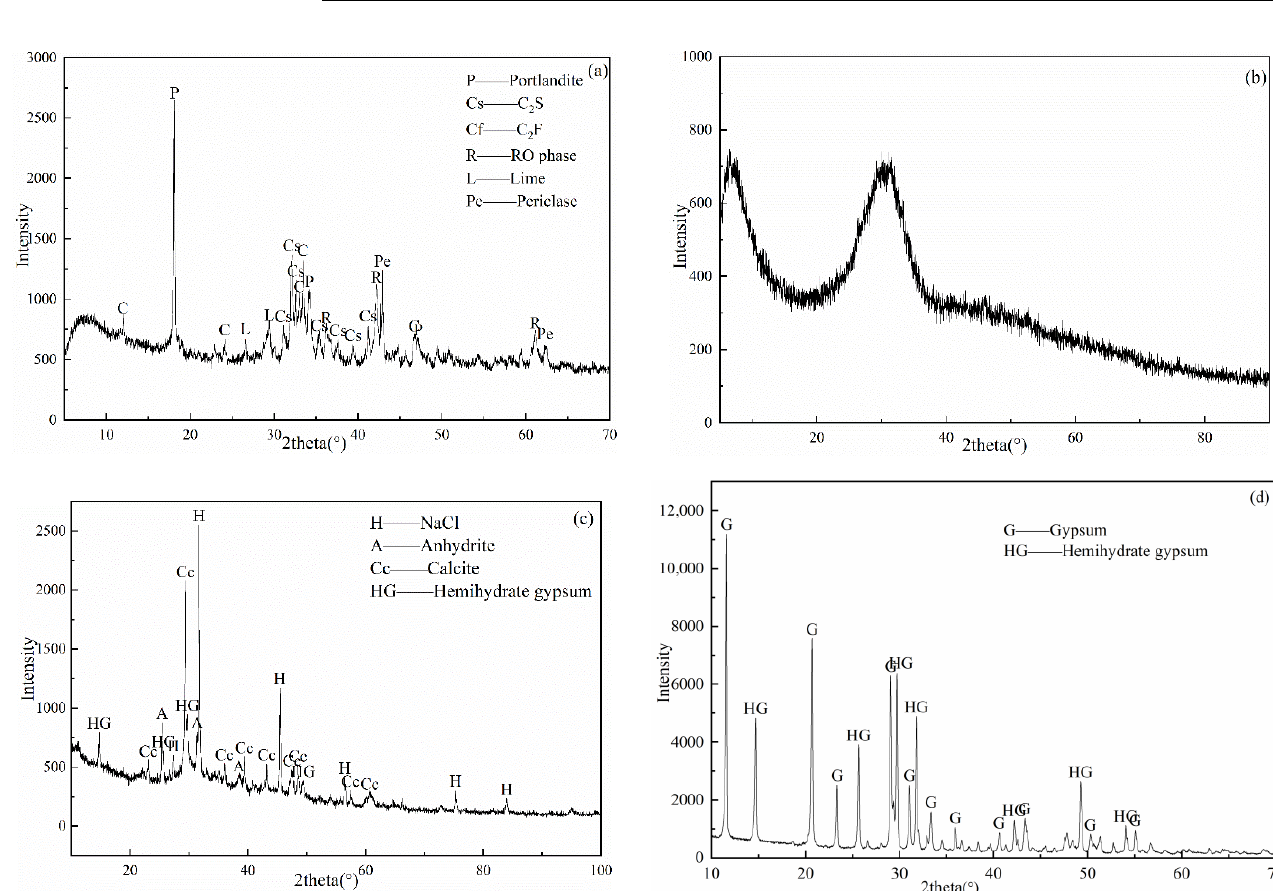
Figure 2. XRD patterns of the raw materials—( a ) BOFS; ( b ) GBFS [13]; ( c ) ASR; and ( d )